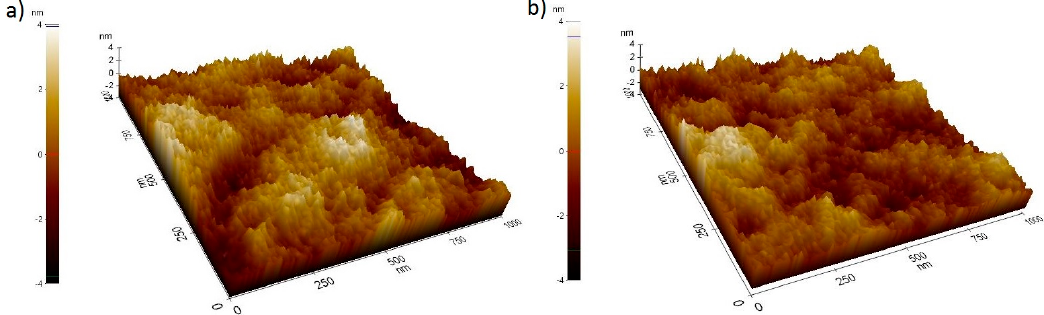
Figure 11. AFM images of ( a ) the reference PTB7:PC 71 BM active layer and ( b ) the champion ternary device containing 2% of GO-TNF ink.